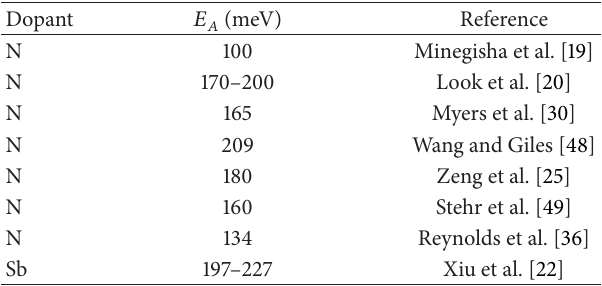
Table 2: Reported acceptor ionization energies for Group VA elements on an oxygen